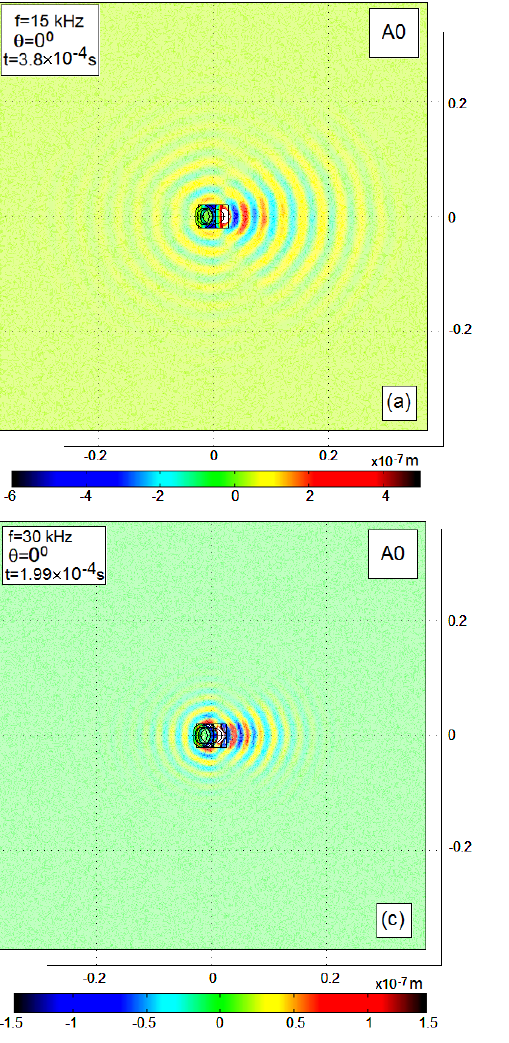
Figure 9. The snapshots of the Lamb A0 ( a , c ) and SS0 ( b , d ) waves, which propagated in the studied CFRP panel at the frequencies 15 kHz ( a , b ) and 30 kHz ( c , d ). Color scales show the normal out-of-plane displacements ( a , c ) and the radial in-plane displacements ( b , d ) at the time instants when these displacements have the amplitude values.